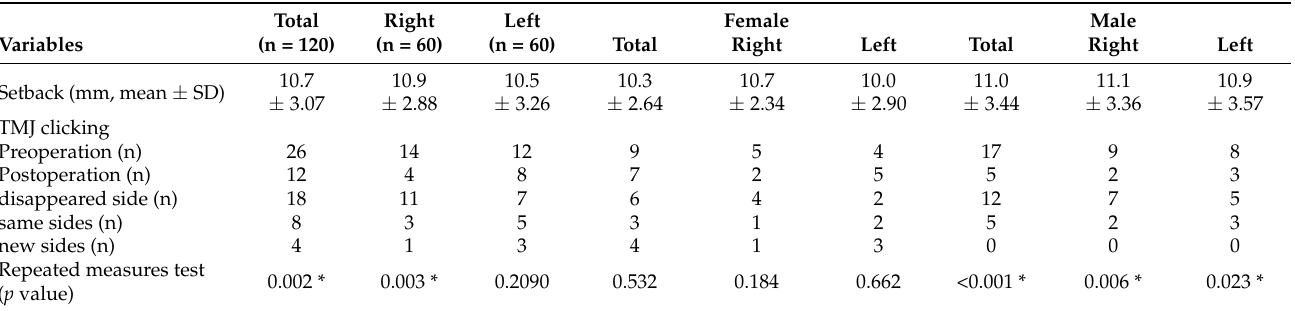
Table 2. Results on total temporomandibular joint clicking (men: 60 sides; women: 60 sides) in a repeated measures